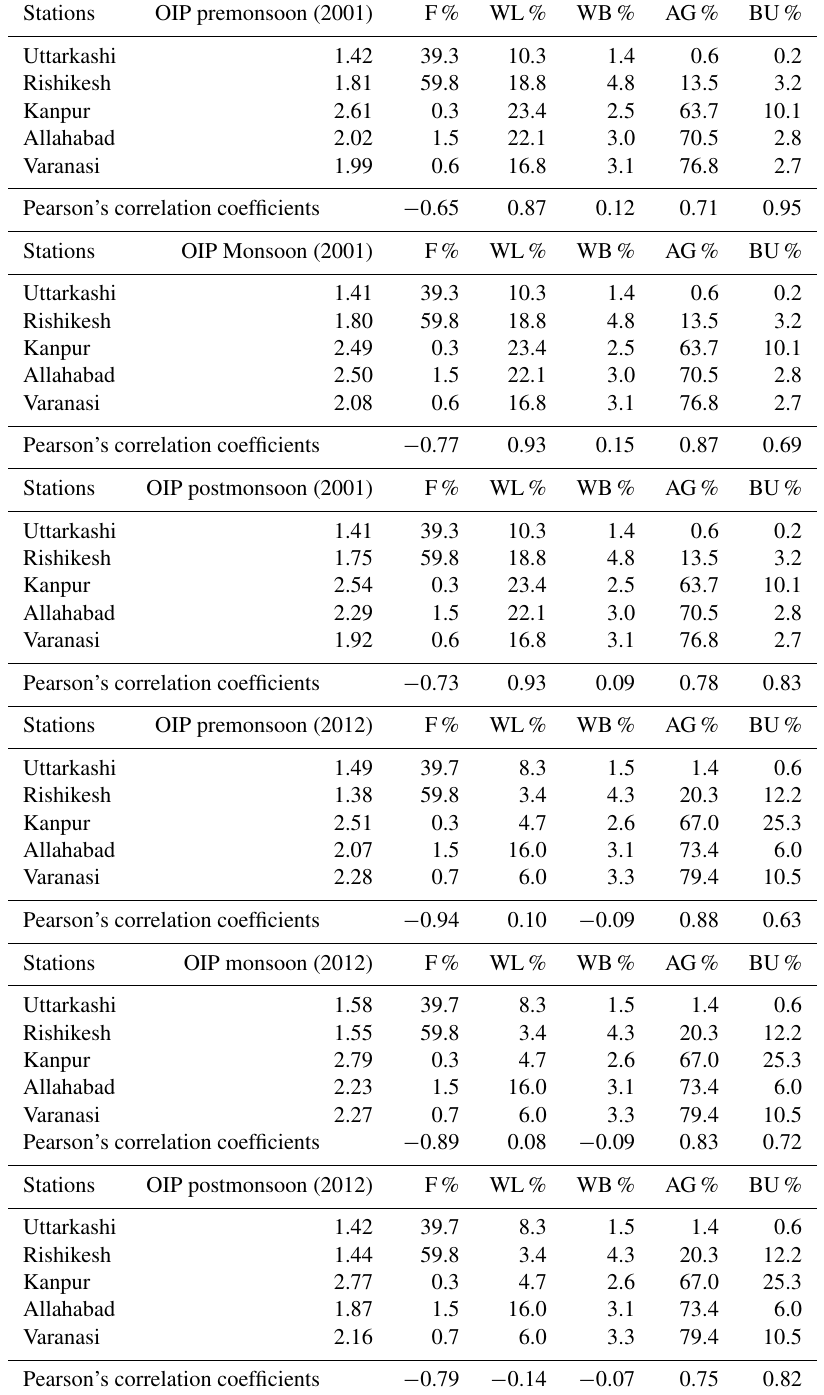
Table 10. Pearson’s correlation coefficients relating LULC to water quality (OIP) in the Upper Ganga River basin (premonsoon, monsoon and postmonsoon seasons of 2001 and